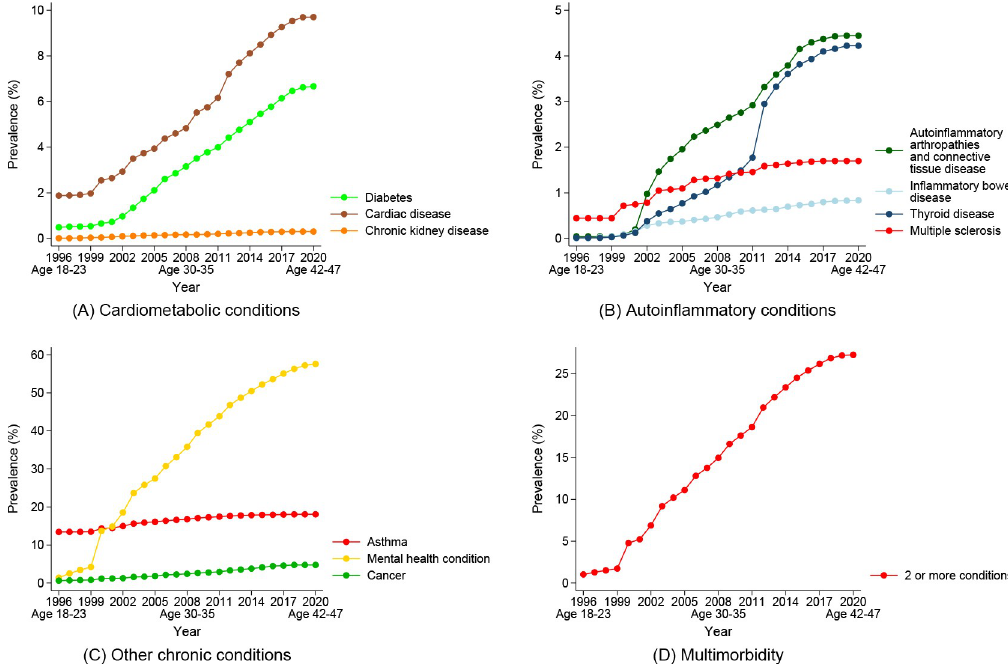
Fig 5. Prevalence of chronic conditions over time for women born 1973–78 from the Australian Longitudinal Study on Women’s Health.